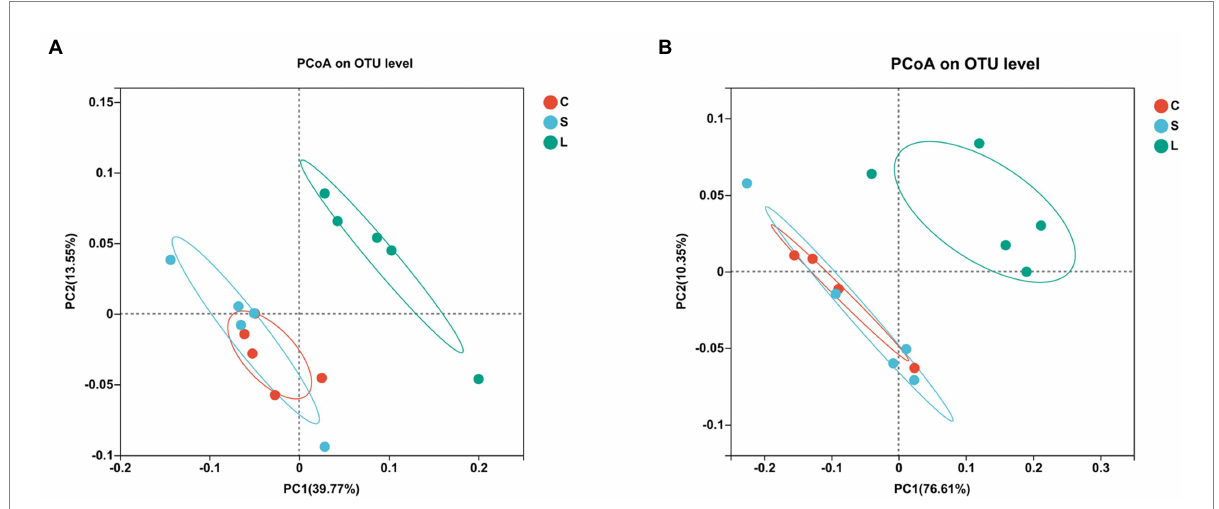
FIGURE 1 Principal coordinate analysis (PCoA) of the ruminal bacteria (A) and archaea (B) communities on OTU level among two glucogenic (C, S) and a lipogenic (L) diet after 48 h in vitro fermentation with rumen fluid of dairy cows. Diets: C, corn and corn silage diet; L, sugar beet pulp and alfalfa silage diet; and S, steam-flaked corn and corn silage diet.